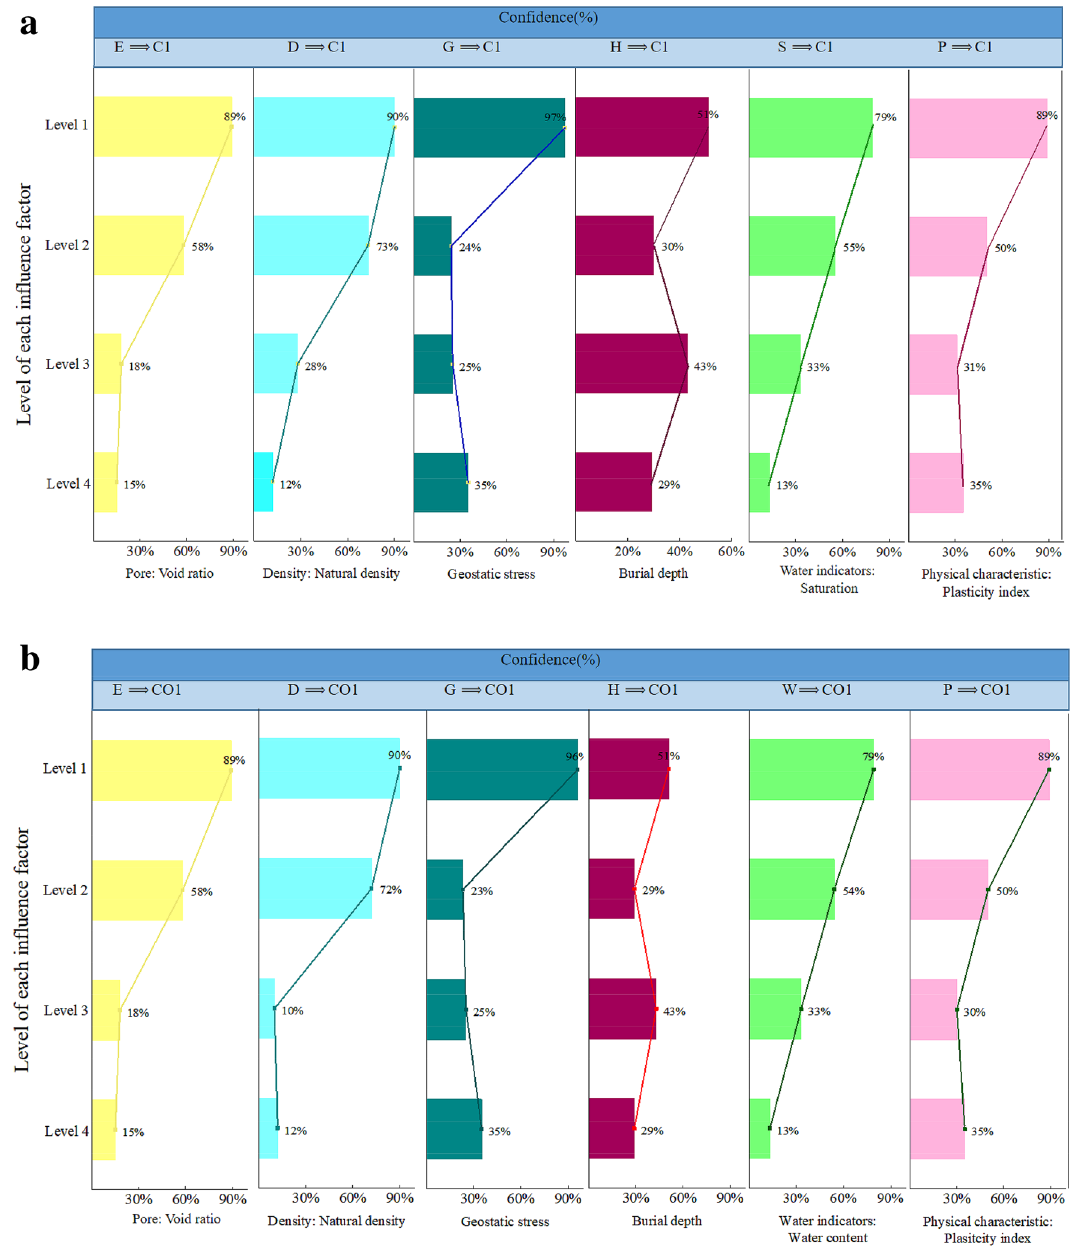
Figure 6. ( a ) Association rules between individual factors and δs within each category. ( b ) Association rules between individual factors and δzs within each